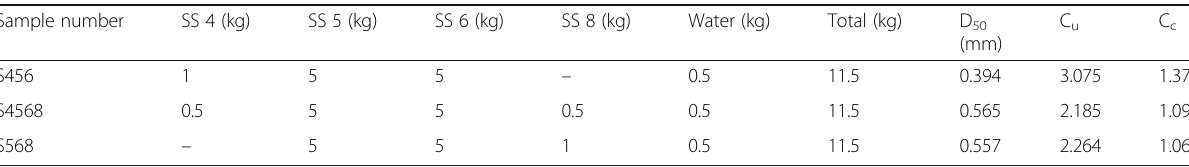
Table 1 Mixed ratios and mechanical properties of samples Sample